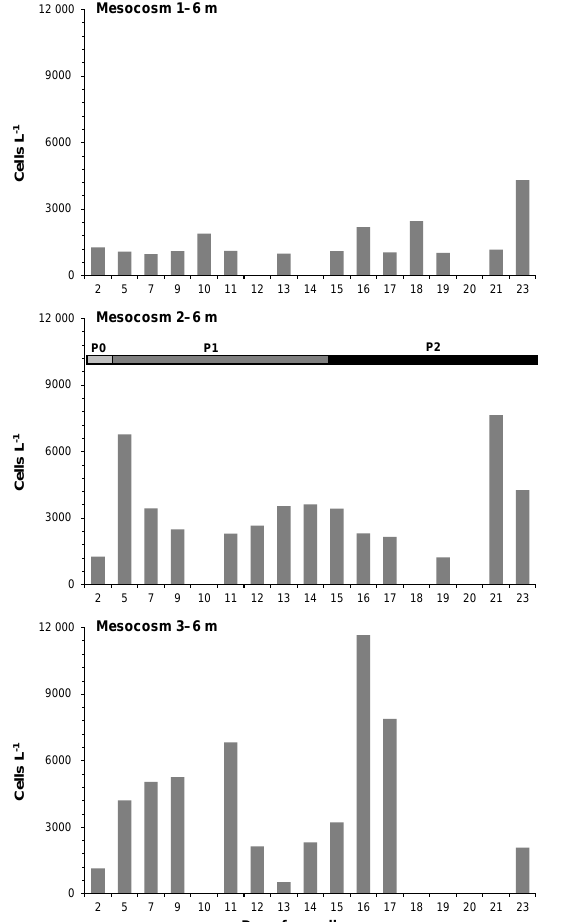
Figure 9 : Total dinoflagellate abundance (in cells L -1 ) at the intermediate depth (6 m) inside each mesocosm. Figure 9. Total dinoflagellate abundance (in cellsL mediate depth (6m) inside each mesocosm.